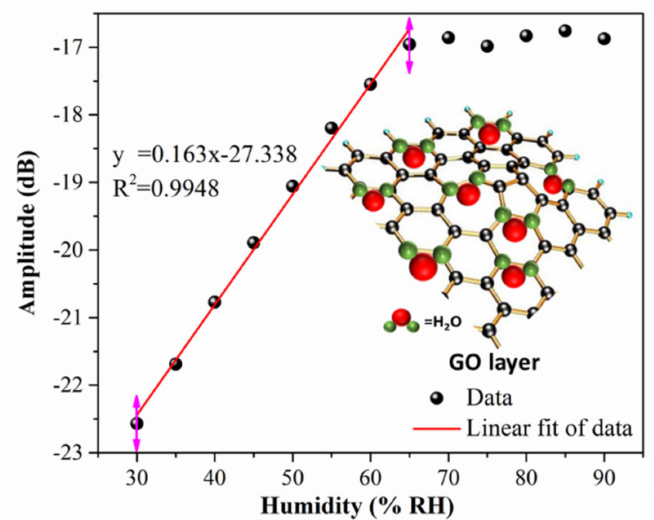
Figure 3. Relative humidity sensitivity of TFBG coated with GO